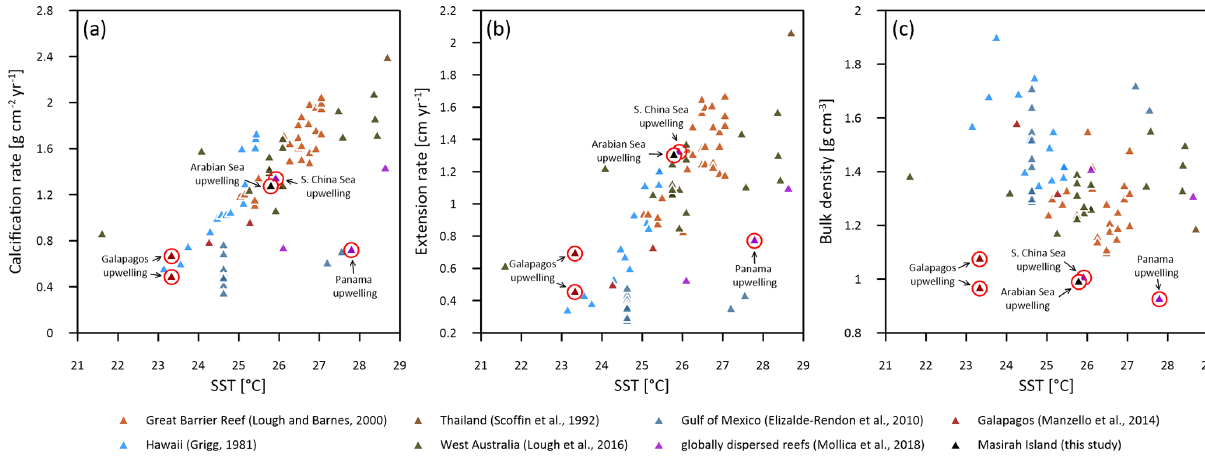
Figure 9. Annual means of Porites calcification rate (a) , extension rate (b) and skeletal bulk density (c) versus sea surface temperature (SST) from various Indo-Pacific and western Atlantic reef sites. Red circles indicate sites affected by seasonal upwelling.